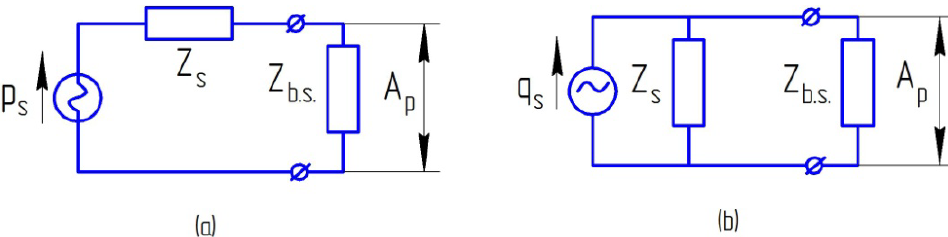
Figure 5. Models of pumps in the form of equivalent oscillation sources: ( a ) in the form of an equivalent source of pressure fluctuations, and ( b ) in the form of an equivalent source of flow fluctuations. Data from the book [6]. p —variable part of the pulsating pressure of the oscillation source, q —variable part of the pulsating flow rate of the oscillation source, Z b.s. —bench system impedance and A p —amplitude of pressure oscillations.